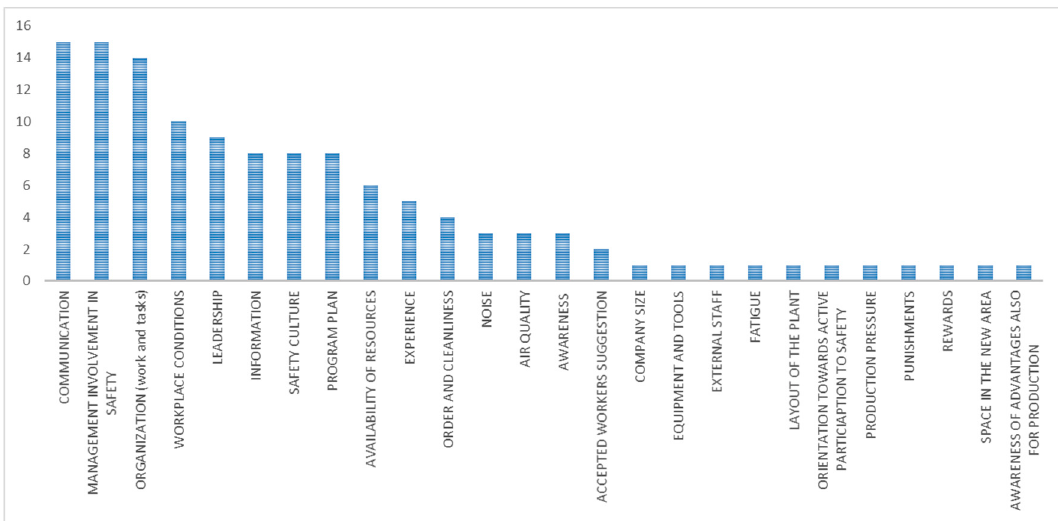
Figure 8. Main contextual factors (in terms of number of occurrences) in technical interventions with expected outcome.